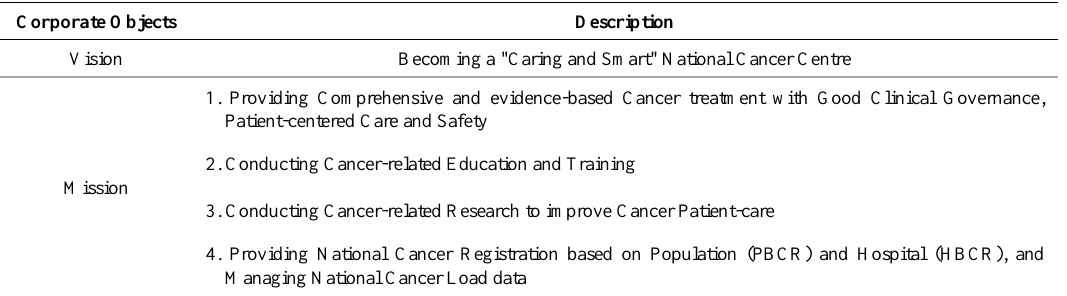
Table 1. Vision and Mission of RSK Dharmais.